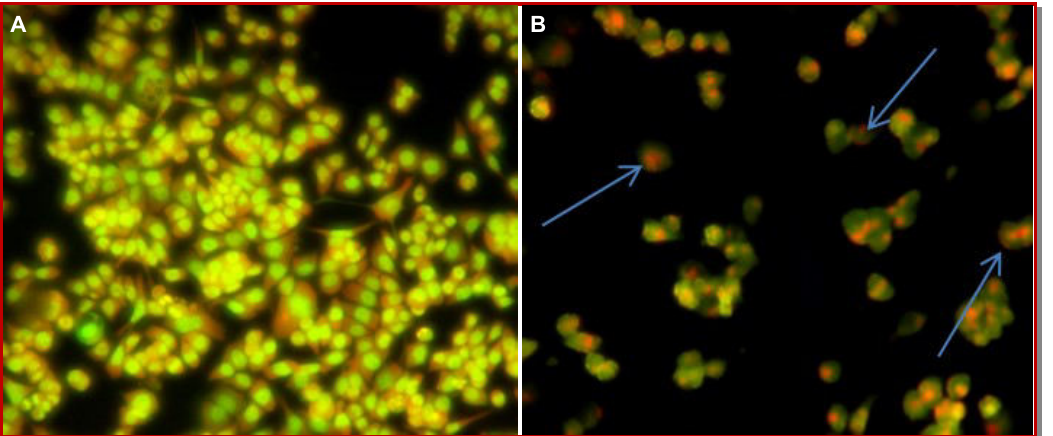
Figure 5: Stains the acridine orange/ethidium bromide staining in control (A) and Z. decandra- treated (B) HCT-116 cells. Arrow marks indicate the DNA damage as evidenced by nuclear staining with ethidium